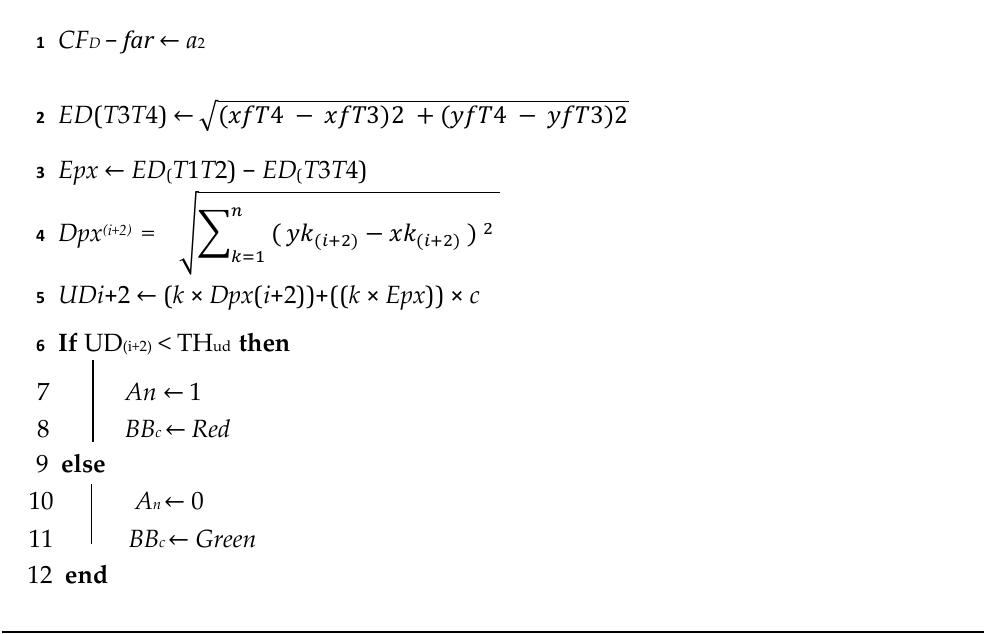
Algorithm 2 : Monitoring people at CF D − far